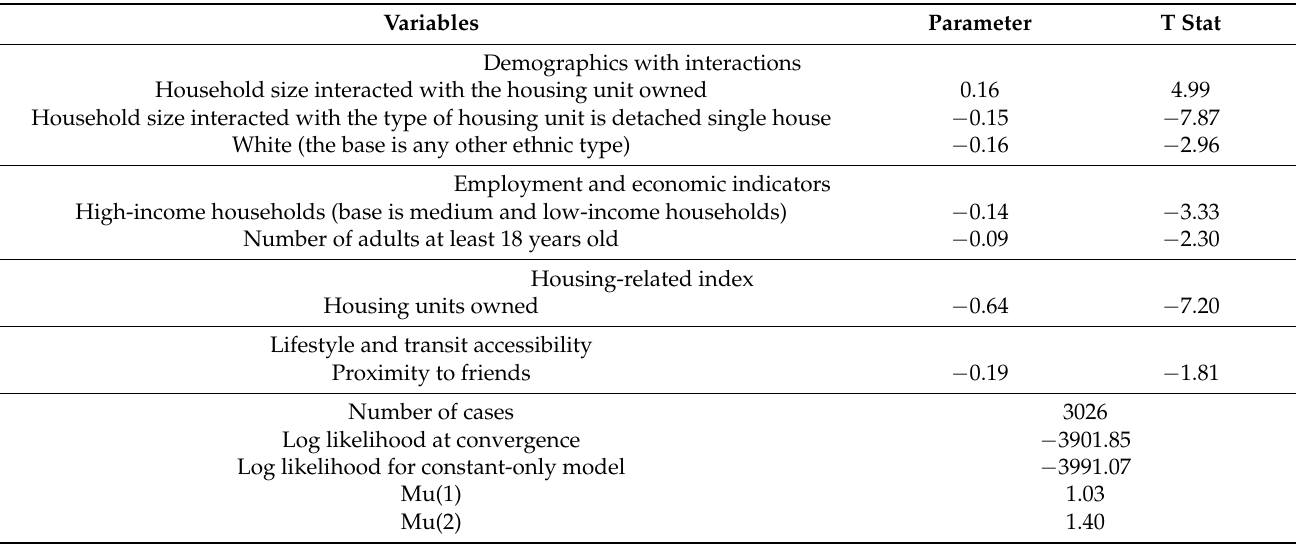
Table 8. Ordered response model of residential choice of 0.25-mile land-use diversity.